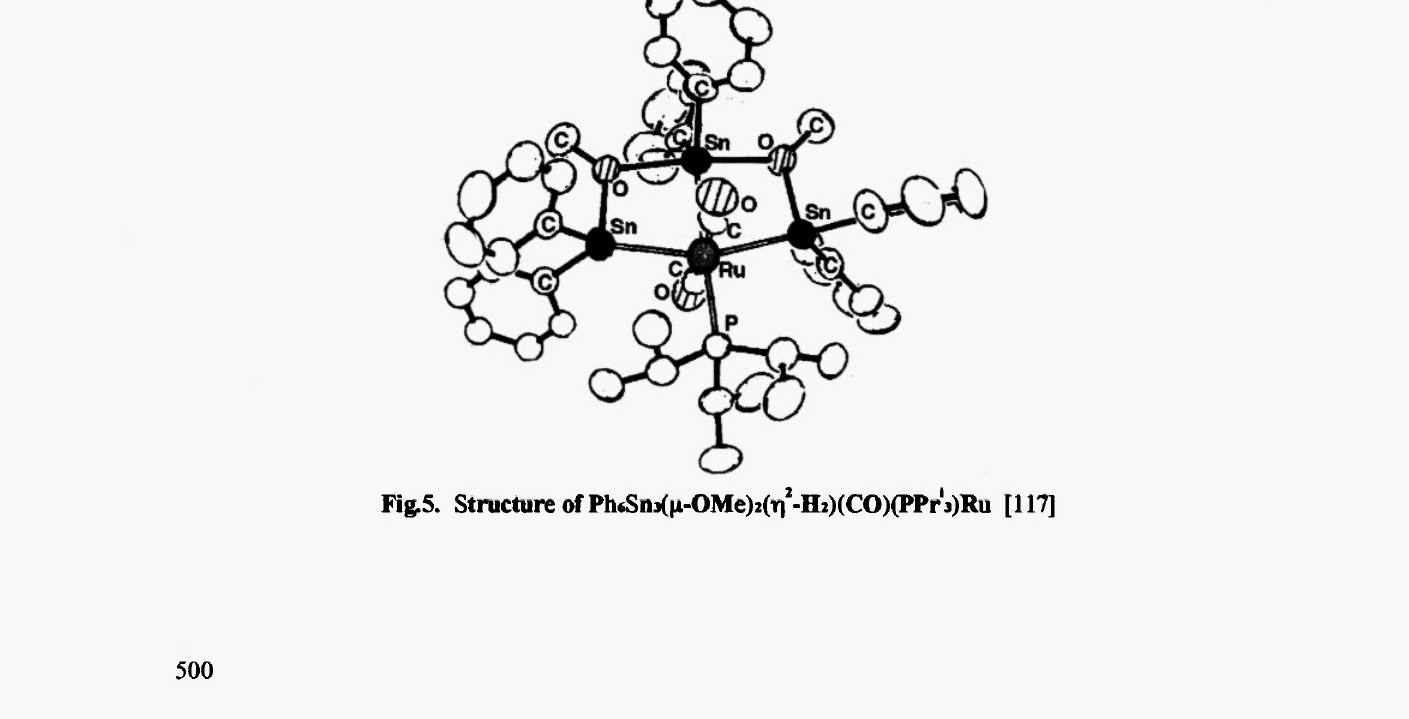
Fig.5. Structure of Ph«Snj^-OMe )2 (T | 2 -H2 )(CO)(PPr 'j )Ru